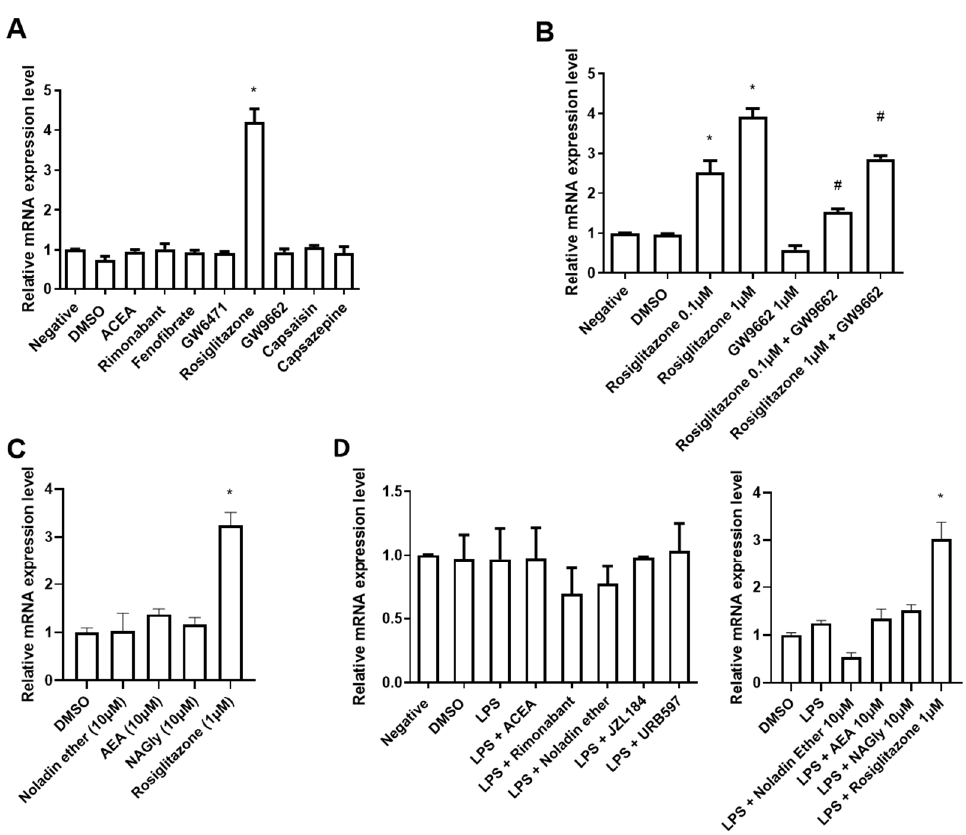
Figure 4. LEAP2 expression in Caco-2/15 cells. Differentiated cells were treated with the indicated compounds at 1 µ M (unless otherwise indicated) for 24 h. Effect of modulation of receptor activity through pharmacological manipulation. (( A ), ACEA; CB1 and TRPV1 agonist, Rimonabant; CB1 antagonist, Fenofibrate; PPAR α agonist, GW6471; PARA antagonist, Rosiglitazone; PPAR γ agonist and GW9662; PPAR γ antagonist, Capsaicin; TRPV1 agonist and Capsazepine; TRPV1 antagonist). Specificity of LEAP2 gene expression responsiveness to PPAR γ activation ( B ). Effects of noladin ether N -arachidonoylethanolamine (AEA) and N -arachidonoyl-glycine (NAGly) ( C ). Effects of inflammatory stimulation by lipopolysaccharide (LPS at 10 µ g/mL) without and with eCBome pharmacological manipulation (( D ), URB597; FAAH inhibitor, JZL184; MAGL inhibitor). Values are represented as mean ± S.E.M and were compared relative to DMSO. n = 3. * p ≤ 0.05 vs. DMSO; # p ≤ 0.05 vs. relevant Rosiglitazone control.